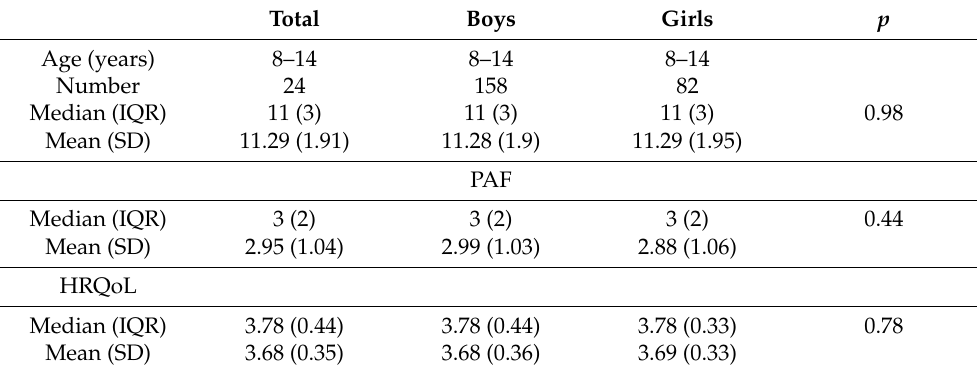
Table 1. Sociodemographic characteristics of the Spanish children and adolescents with Asthma participants.